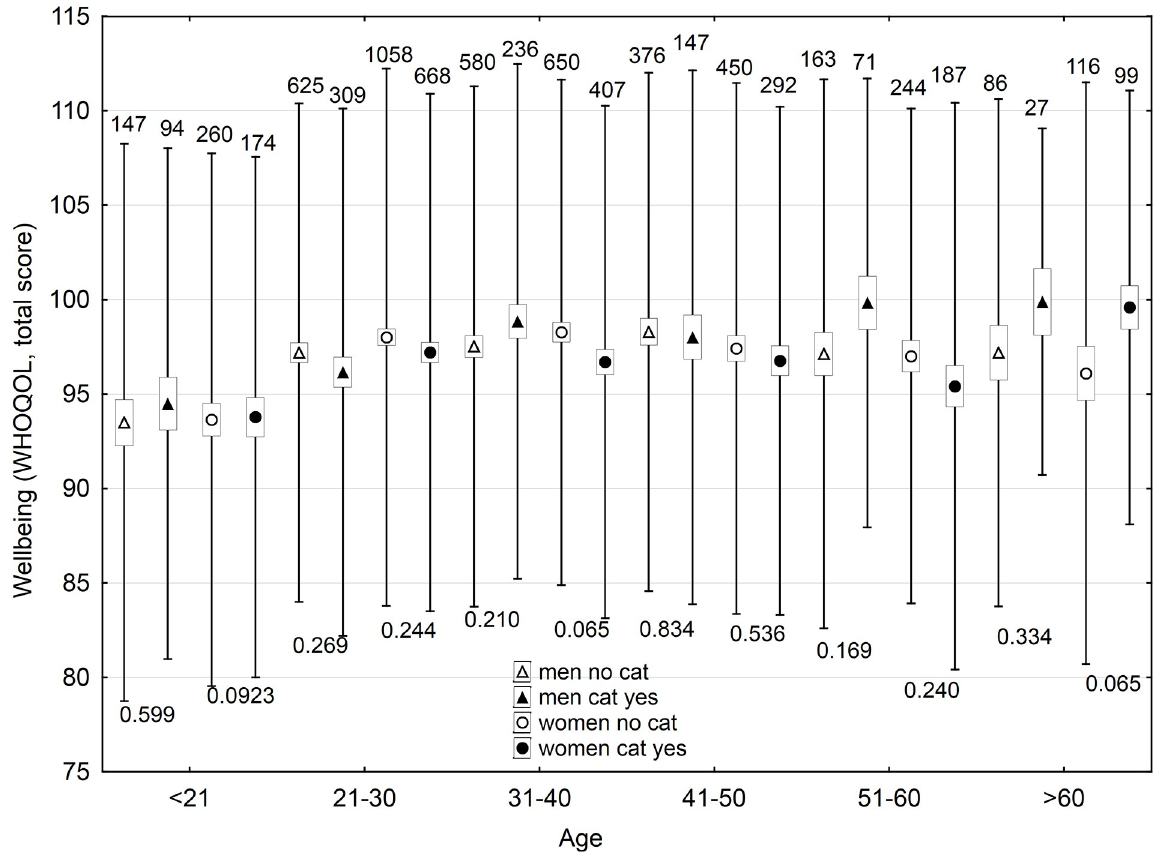
Fig 2. Effect of keeping a cat now on wellbeing of men and women of different age. The boxes, spreads, upper numbers and lower numbers show standard errors, standard deviations, numbers of subjects in particular category and p-values of two-sided t-tests, respectively.